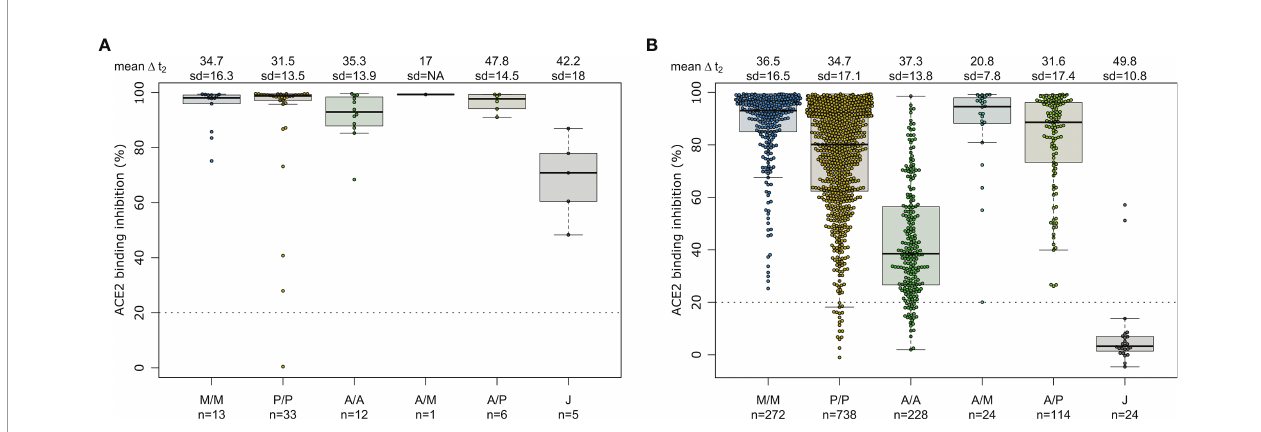
FIGURE 5 | SARS-CoV-2 vaccination boosts ACE2 binding inhibition among recovered individuals independent of vaccination scheme. Differences in vaccination responses of recovered previously SARS-CoV-2 infected individuals from our mix and match cohort were analyzed using an ACE2-RBD competition assay (A) . SARS-CoV-2 infection status was based on a previous self-reported positive PCR/antigen test or a MULTICOV-AB nucleocapsid IgG normalisation ratio above 1. Samples were split according to vaccination scheme in homologous mRNA (mRNA-1273 (M/M, blue), BNT162b2 (P/P, orange)), heterologous prime-boost (AZD1222-mRNA-1273 (A/M, light blue), AZD1222-BNT162b2 (A/P, light green) or vector-based (AZD1222-AZD1222 (A/A, green), Ad26.CoV2.S (J, grey)). For clarity and comparison, ACE2 inhibition of SARS-CoV-2 naïve individuals are displayed (B) . Boxes represent medians, 25th and 75th percentiles and whiskers show the largest and smallest non-outlier values based on 1.5 IQR calculation. If not enough sample to generate a box were present (minimum 5), then only the median is indicated by a line. The threshold for non-responsive samples (ACE2 binding inhibition less than 20%) is shown as dotted line. All samples below this can be considered non-responsive. Time between sampling and full vaccination is displayed as mean and SD for each group. Number of samples per vaccination scheme are stated below the graph. Results of a formal statistical comparison of recovered-vaccinated and SARS-CoV-2 naïve-vaccinated individuals are shown in Supplementary Table 6